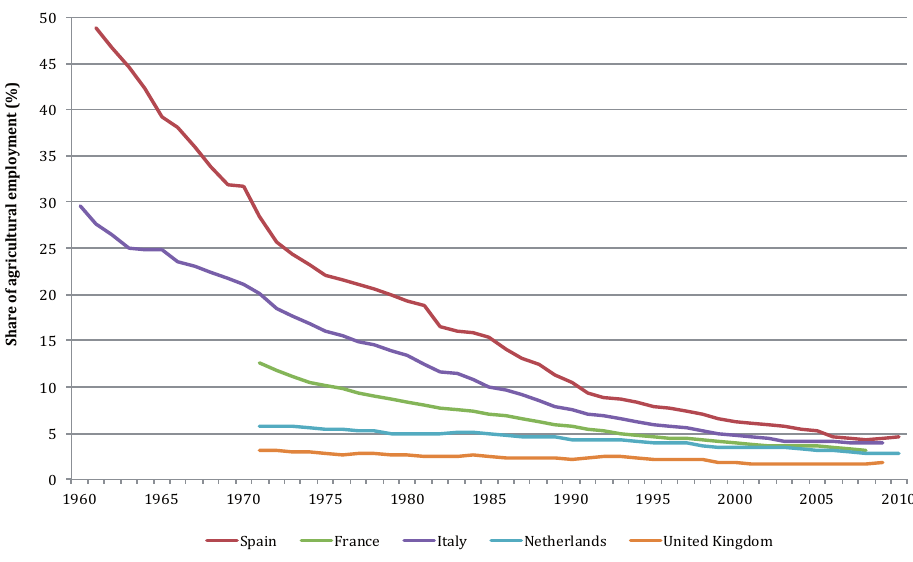
Figure 1. Share of agricultural employment in total employment (%;